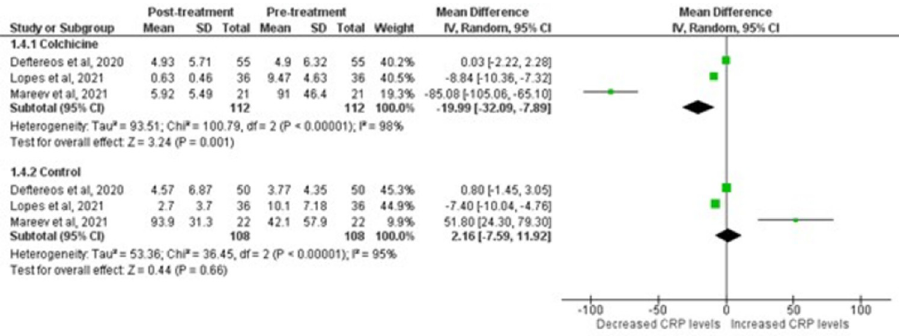
Fig 7. Forest plot for effects of colchicine on CRP levels in COVID-19 patients. Green squares and their corresponding lines are the point estimates and 95% confidence intervals per each study. Black diamonds represent the pooled effect estimate.